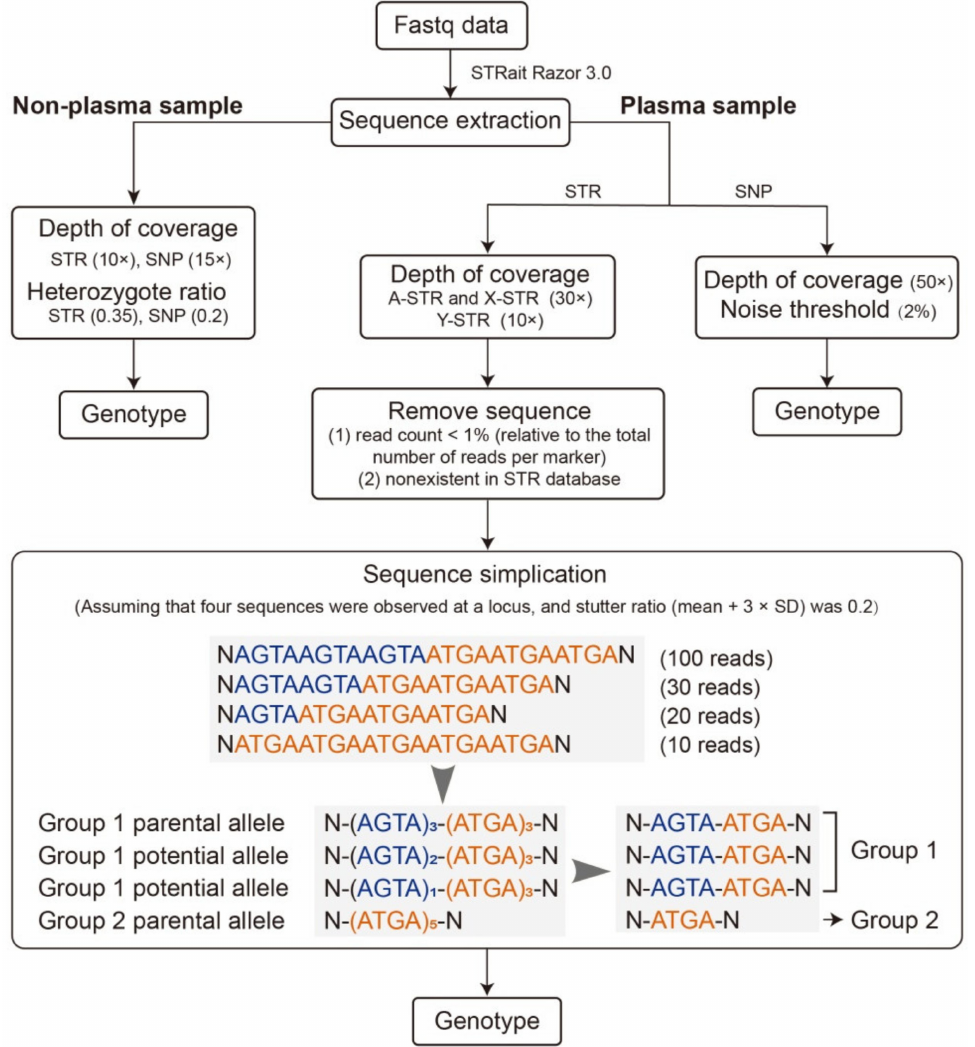
Figure 1. The workflow for genotype